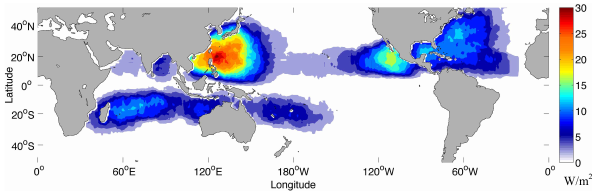
Figure 8. Geographical distribution of air–sea heat flux caused by TCs. We assume each grid box can only be affected by one storm within a 20-day